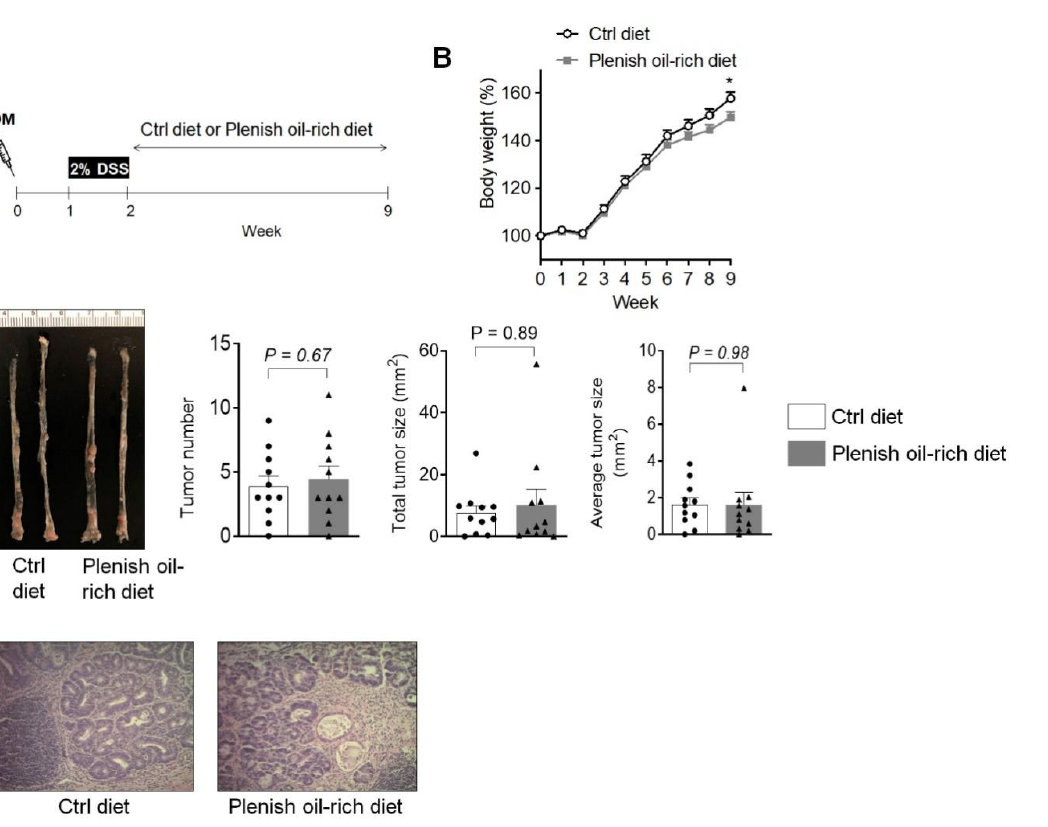
Figure 1. Effects of Plenish soybean oil on AOM/DSS-induced colon tumorigenesis. ( A ) Scheme of the animal experiment. ( B ) Plenish oil-rich diet slightly reduced body weight (n = 11 mice per group). ( C ) Plenish oil-rich diet had little impact on AOM/DSS-induced colon tumorigenesis. ( D ) Histology of the colon tumors ( n = 11 mice per group).